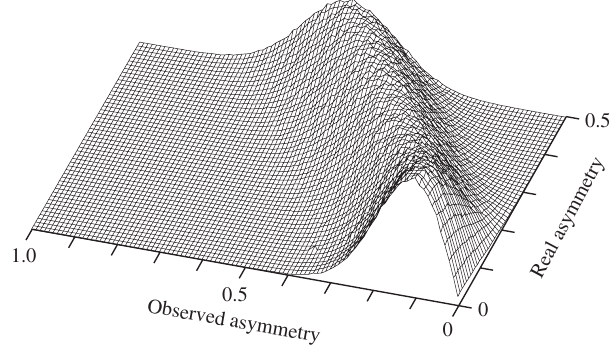
FIG. 9. This projection shows the distribution of magnitudes from a Monte Carlo calculation based on Eq. (3) for a set of nine direction bins, each with a statistical error of 0.25 and varying amounts of real asymmetry. deviation of σ ¼ 0 . 25 about the sine wave. At the highest values of the real asymmetry ( ∼ 0 . 5 ), the observed values are distributed near 0.5 as well with a nearly Gaussian shape. However, for values of the real asymmetry near zero, the magnitudes are shifted systematically upward. The chance of obtaining a zero magnitude vanishes. At zero real asymmetry the mean value of the distribution is given by ffiffiffiffiffiffiffiffiffiffiffiffiffiffiffiffiffi p σ π =N ¼ 0 . 14 (see the Appendix for a derivation). BINS The most probable value is about 0.11. Once the real asymmetry becomes greater than the average value at zero asymmetry, the average magnitude tends quickly toward the real value.